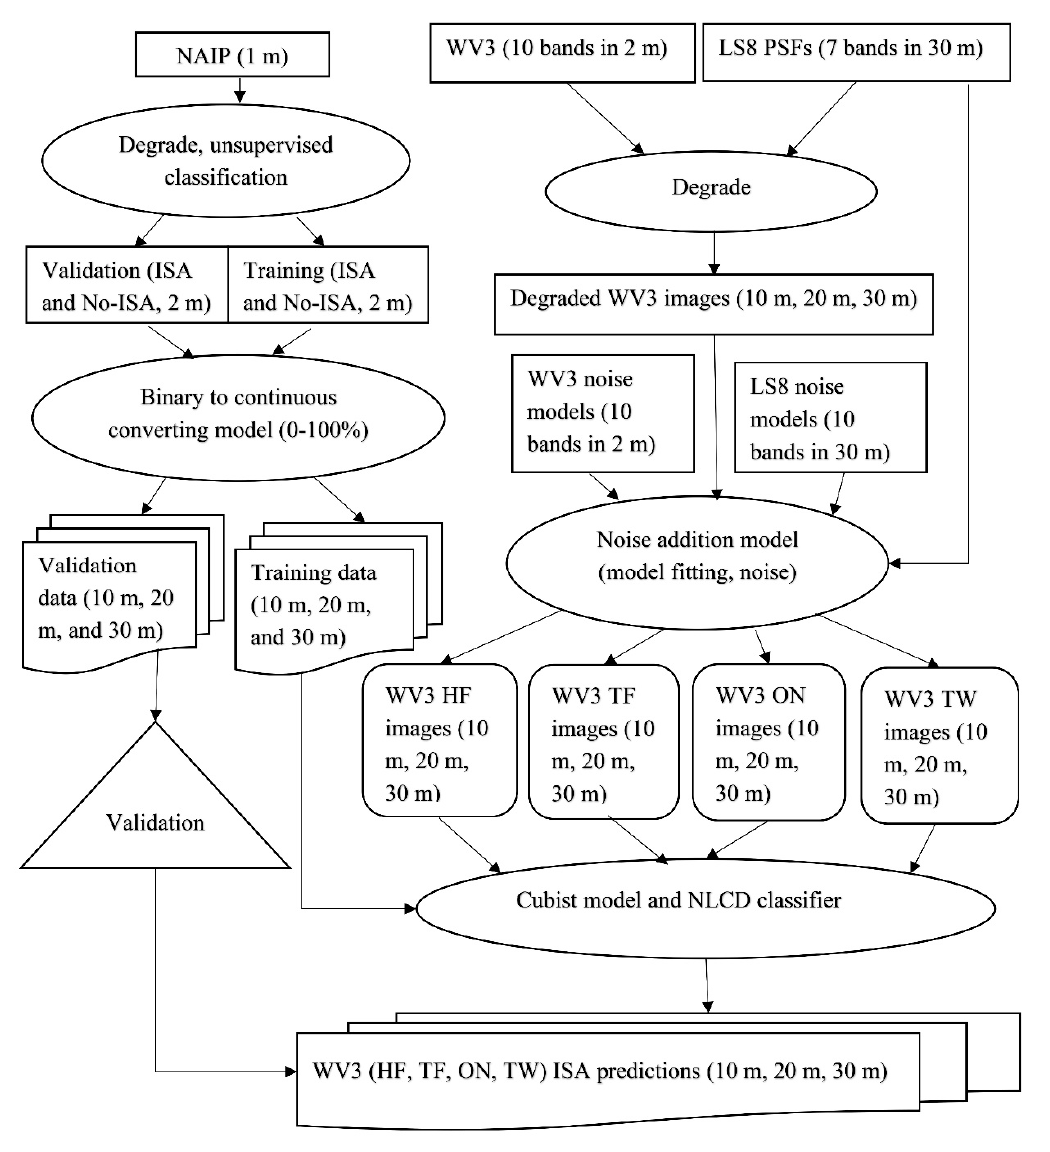
Figure 1. Procedures of mapping and assessing ISAs using WV3 images and Landsat (LS) 8 point spread function (PSF) with different SNRs.